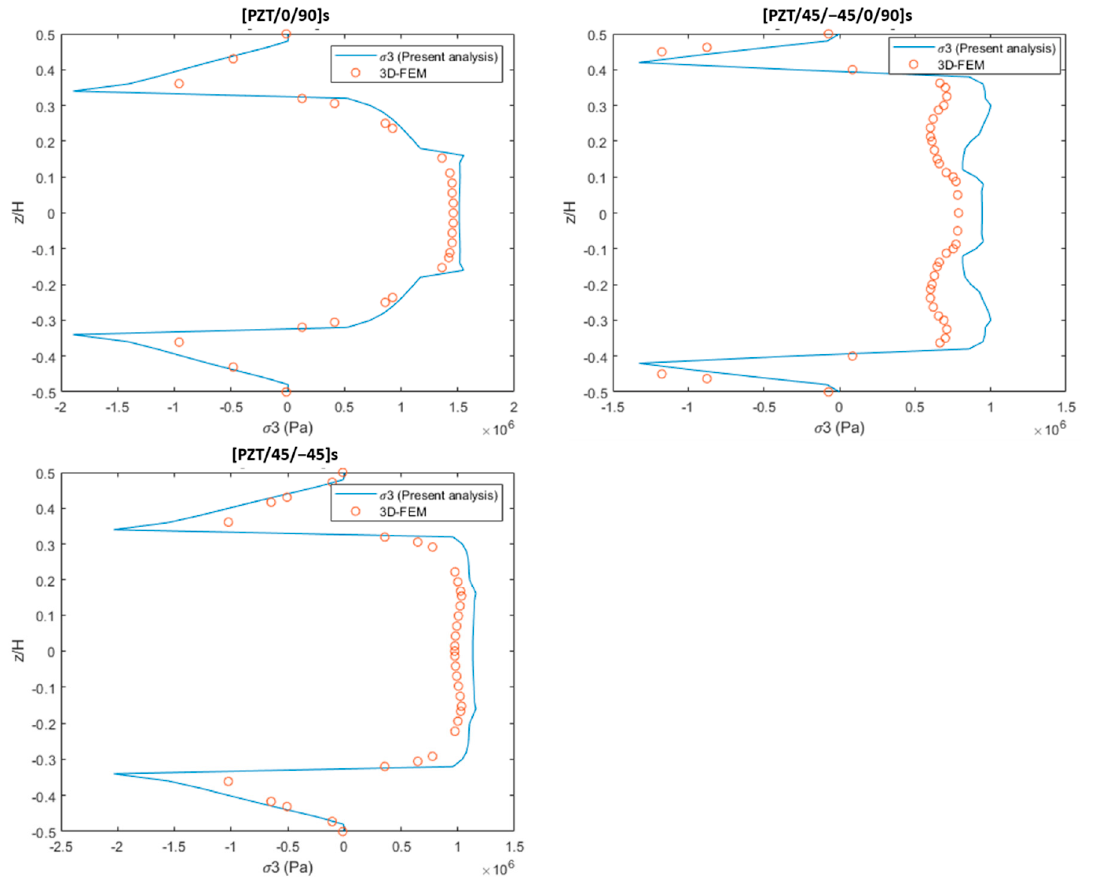
Figure 7. Interlaminar stress distribution in cross-ply, angle-ply, and quasi-isotropic layup under the electrical excitation.